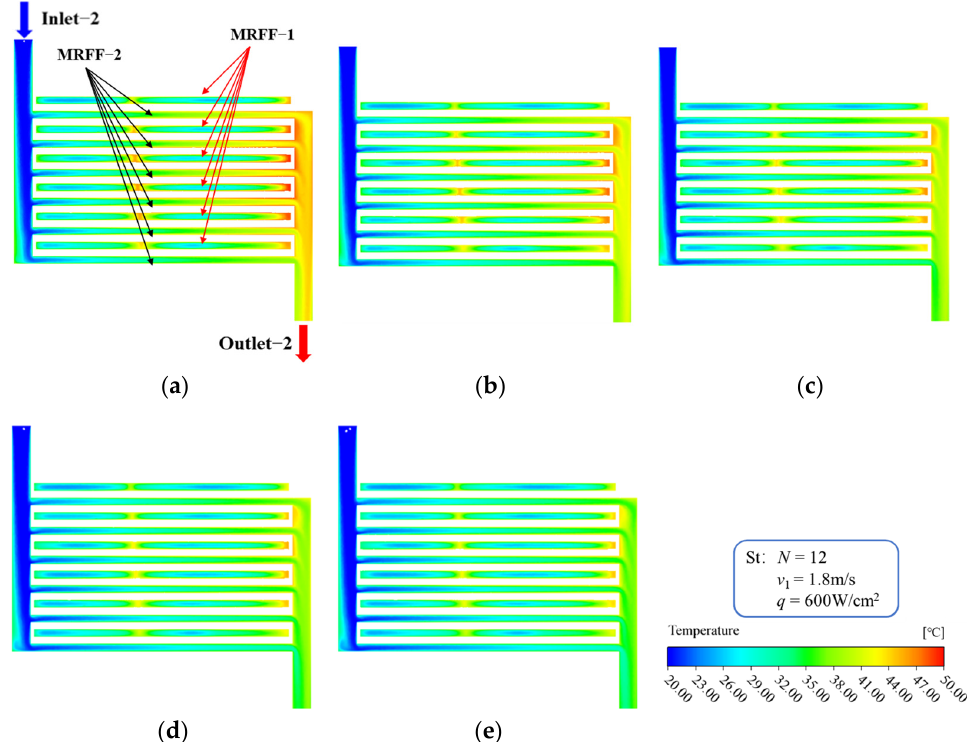
Figure 9. Temperature distribution of microchannel at different inlet − 2 velocities. ( a ) u in − 2 = 1.2 m/s; ( b ) u in − 2 = 1.5 m/s; ( c ) u in − 2 = 1.8 m/s; ( d ) u in − 2 = 2.1 m/s; ( e ) u in − 2 = 2.4 m/s.